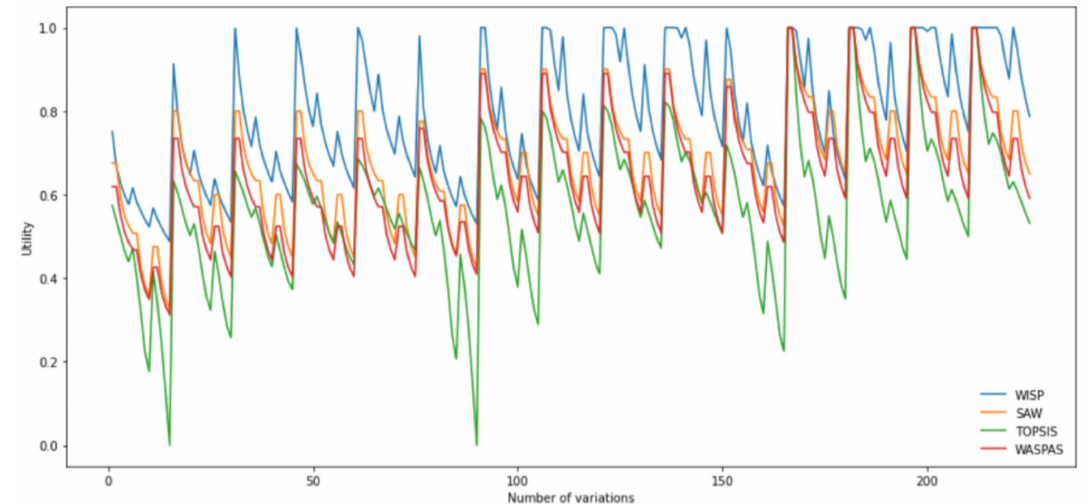
Figure 3. Correlation of utility alternatives achieved by applying different MCDM methods formed based on 225